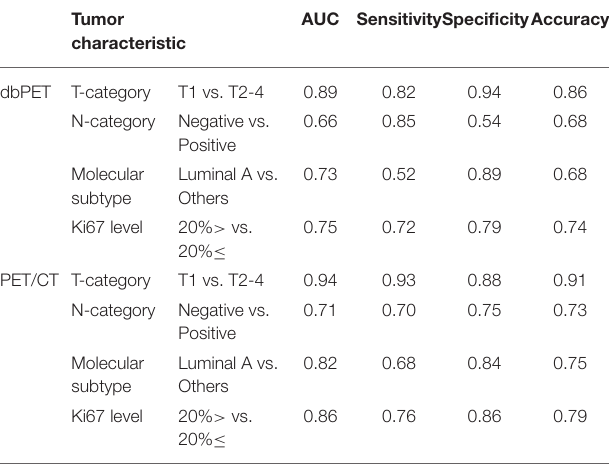
TABLE 3 | ROC analysis for classification of tumor characteristics by texture features using principal component analysis. Tumor